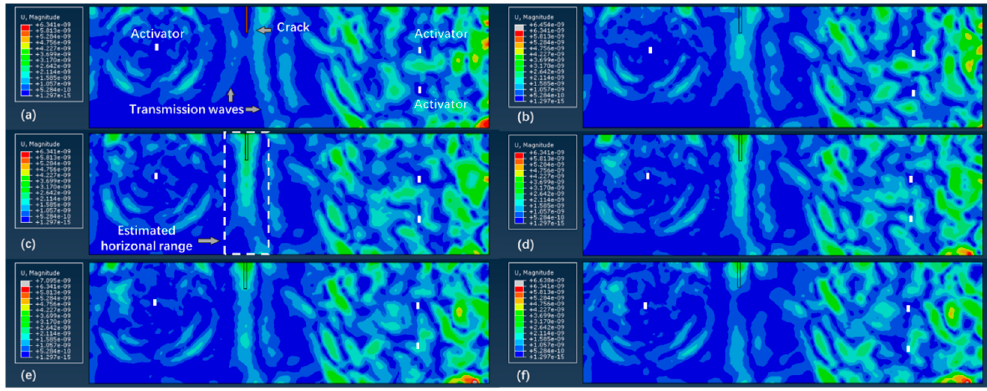
Figure 7. Focus result of the first wave fronts at different time instants: ( a ) 54.07 μ s ; ( b ) 56.16 μ s ; ( c ) 58.08 μ s ; ( d ) 59.04 μ s ; ( e ) 60.00 μ s ; ( f ) 61.13 μ s .